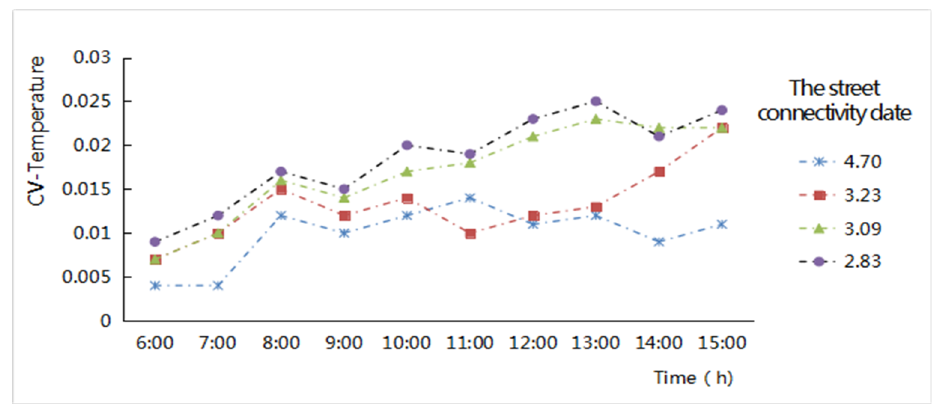
Figure 7. Hourly Coefficient of Variation (CV) values variation of the air temperatures related to the different levels of street connectivity of the street network from 6:00 to 15:00 in the four study areas.